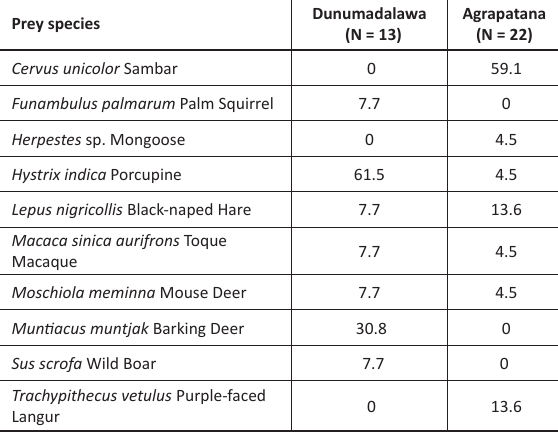
Table 3. Scat analysis results from Dunumadalawa and Agrapatana study sites. Results are % of total scats containing each prey species. Herpestes could not be discerned to species